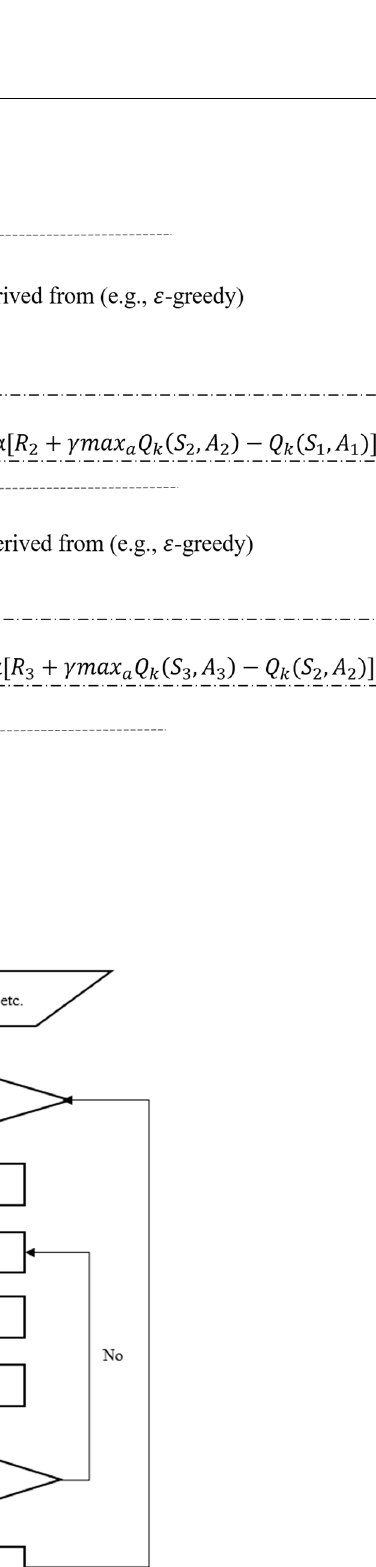
(7) Figure 11. The schematic diagram of the reward and punishment rules.